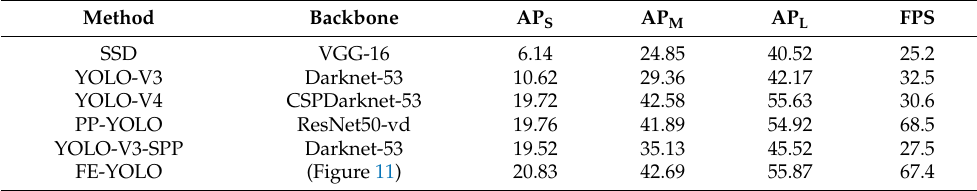
Table 8. The Comparison of speed and accuracy on MS COCO dataset (test-dev